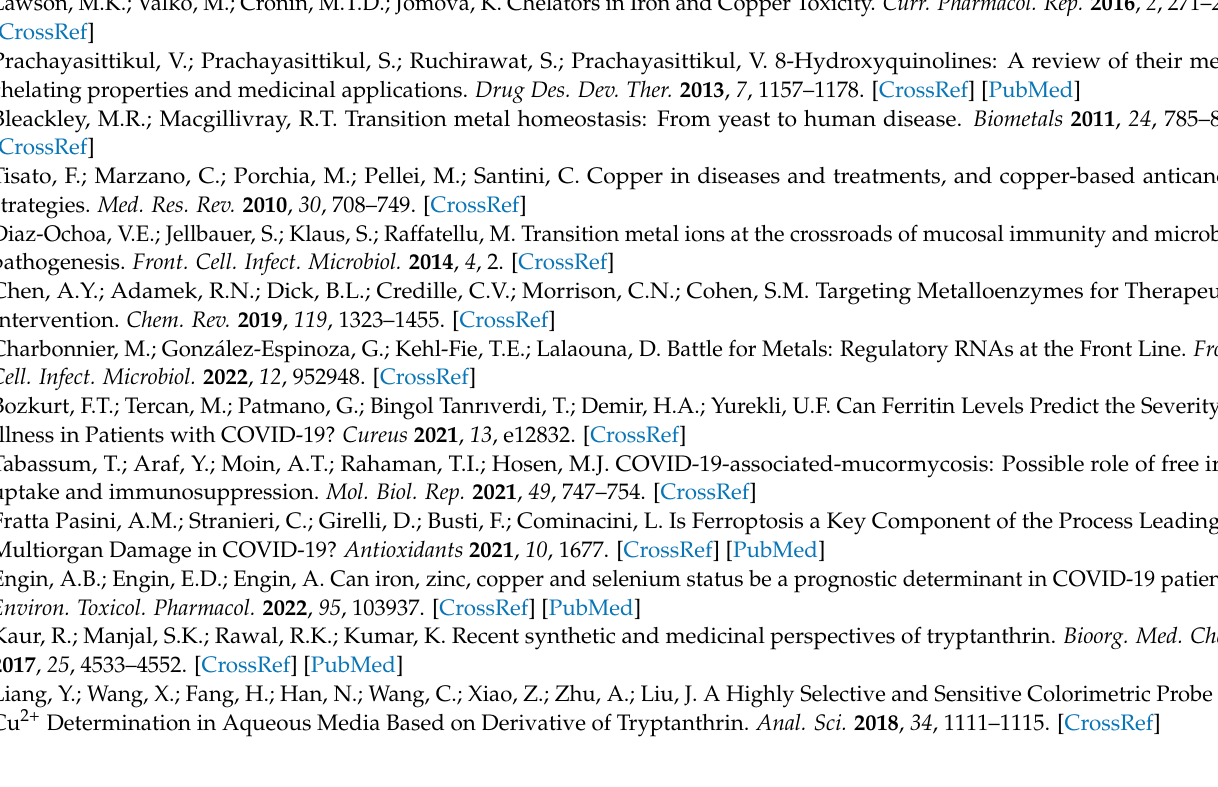
ion; Figure S9: Infrared spectra of T8H-TSC receptor and its complex with Cu(II) ion; Figure S10: Raman spectra of T8H-TSC receptor and its complex with Cu(II) ion; Table S1: Determination of limit of detection and linear range for PAA-TSC and T8H-TSC complexes with Cu (II) and